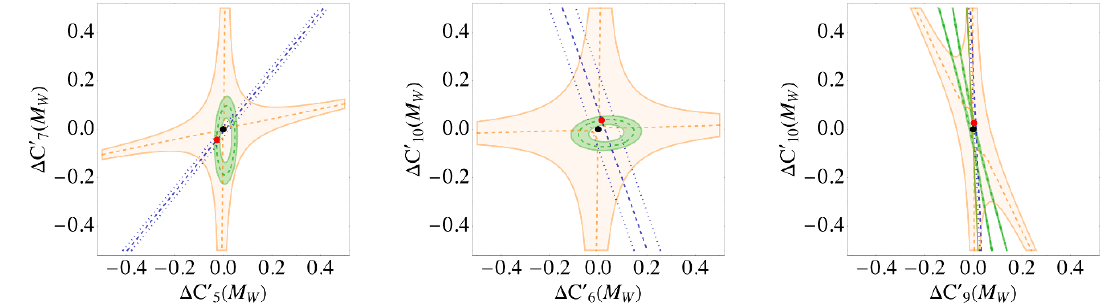
Figure 4. Overlaid individual constraints upon (cid:22) C 0 e(cid:11) lifetime ratio (green), width di(cid:11)erence (orange) upon (cid:1) C 0 (middle), (cid:1) C 0 (cid:1) C 0 plane (right). The SM point and best (cid:12)t point are shown as the black and 9 (cid:0) 10 red dots